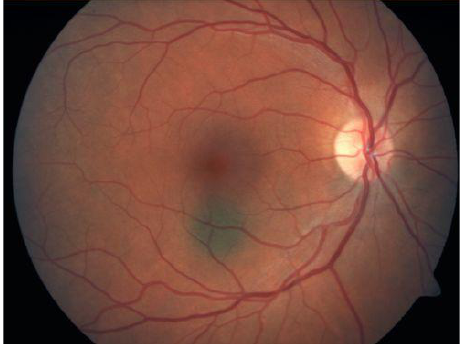
Figure 1. Choroidal nevus.